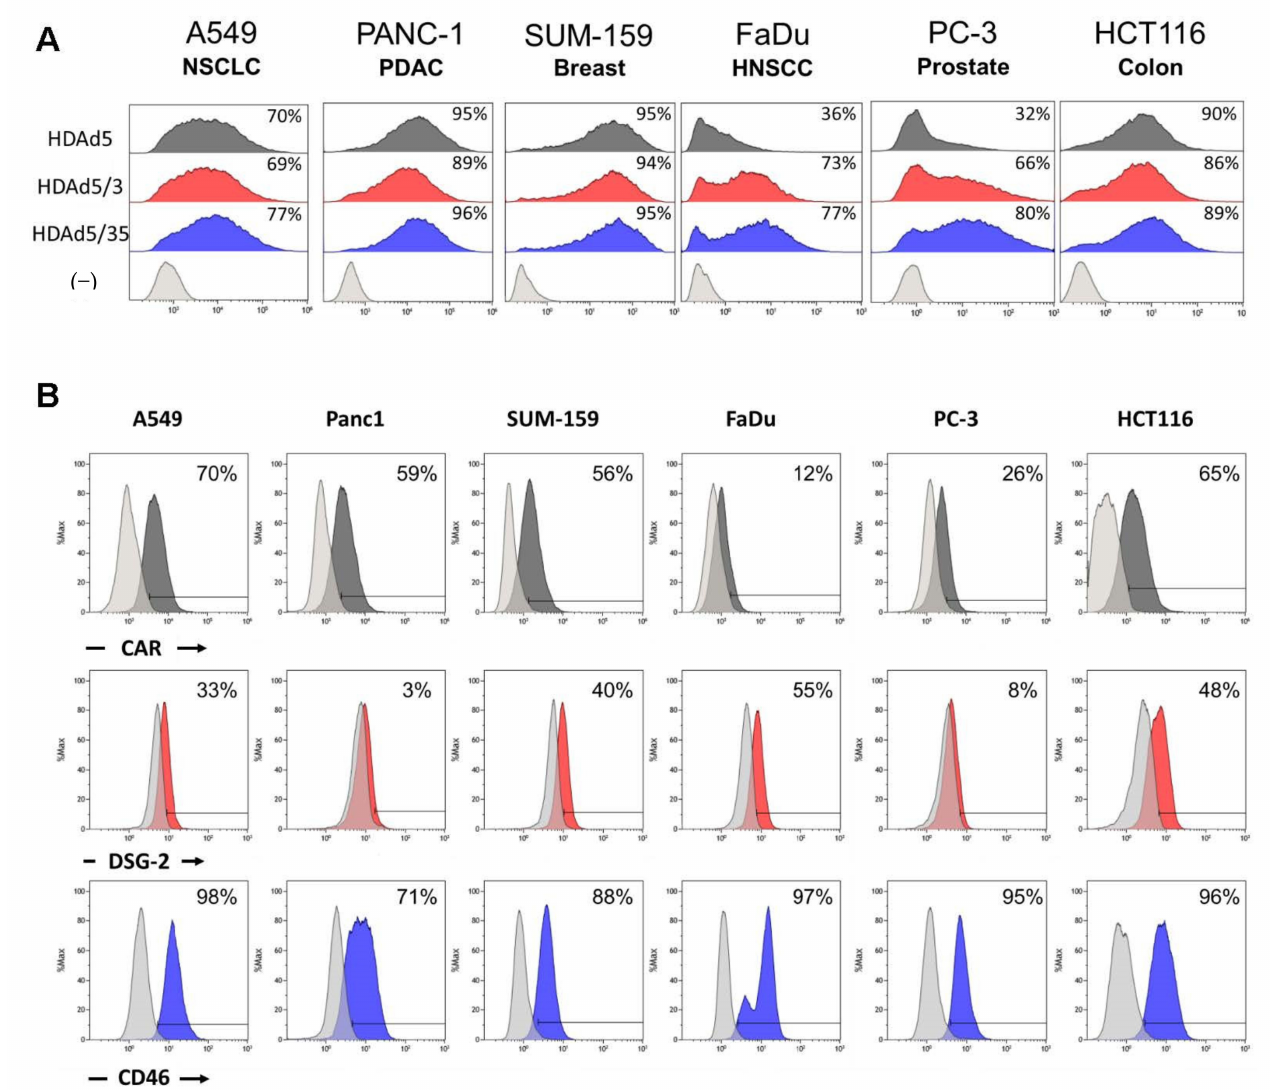
Figure 1. Adenovirus knob chimeras mediate differential tumor type tropism. ( A ) A panel of solid tumor cell lines (A549, Panc-1, SUM-159, FaDu, PC-3, HCT116) were infected with 100 vp/cell of HD5 eGFP, HD5/3 eGFP or HD5/35 eGFP for 1 h. GFP expression was assessed via flow cytometry 24 h post-infection. ( B ) Cell surface expression of Ad receptors on the panel of solid tumor cell lines were assessed via flow